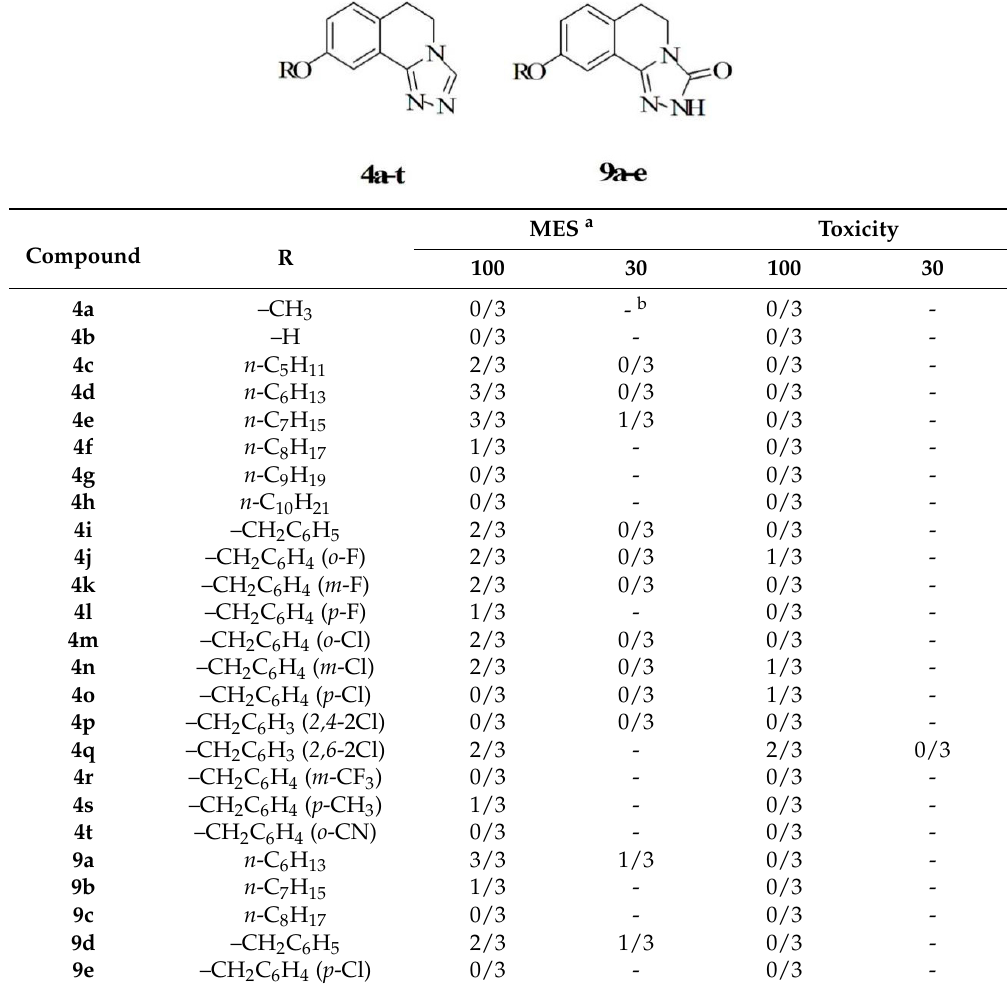
a Maximal electroshock test (number of animals protected/number of animals tested), the number of mice is three; The dose measured in mg/kg; b Not